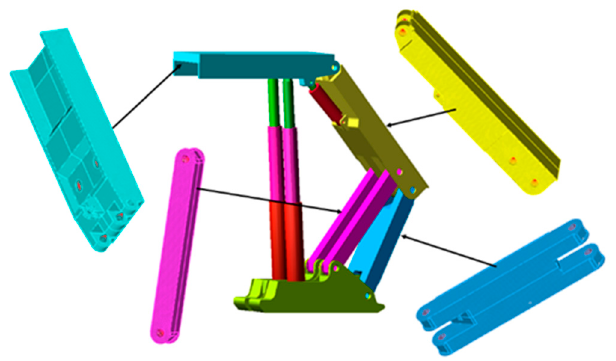
Figure 7. Rigid-flexible coupling dynamics model.